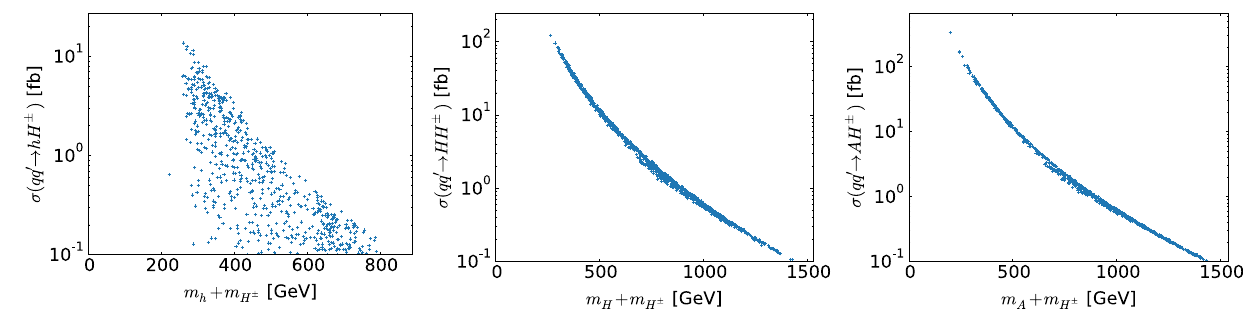
Fig. 1 Cross sections for the three possible charged